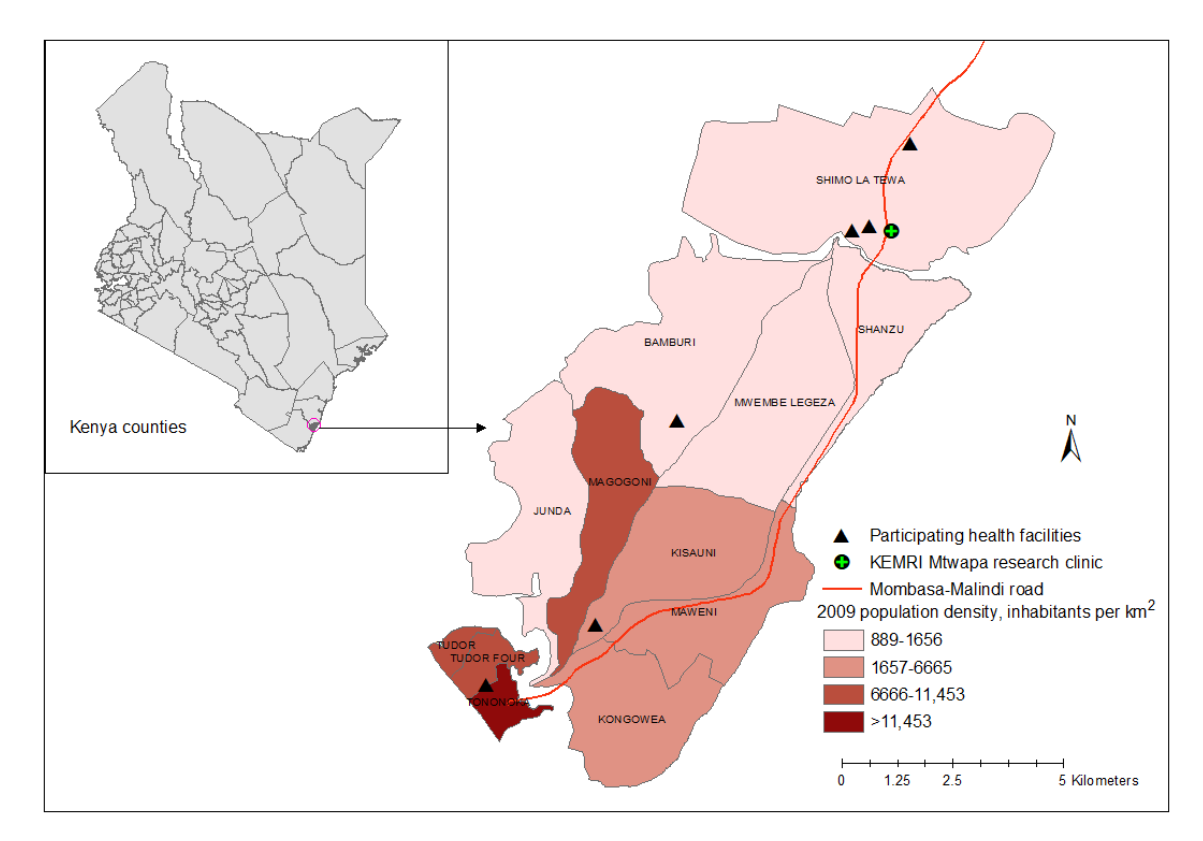
Figure 1. Map of Tambua Mapema Plus study sites.